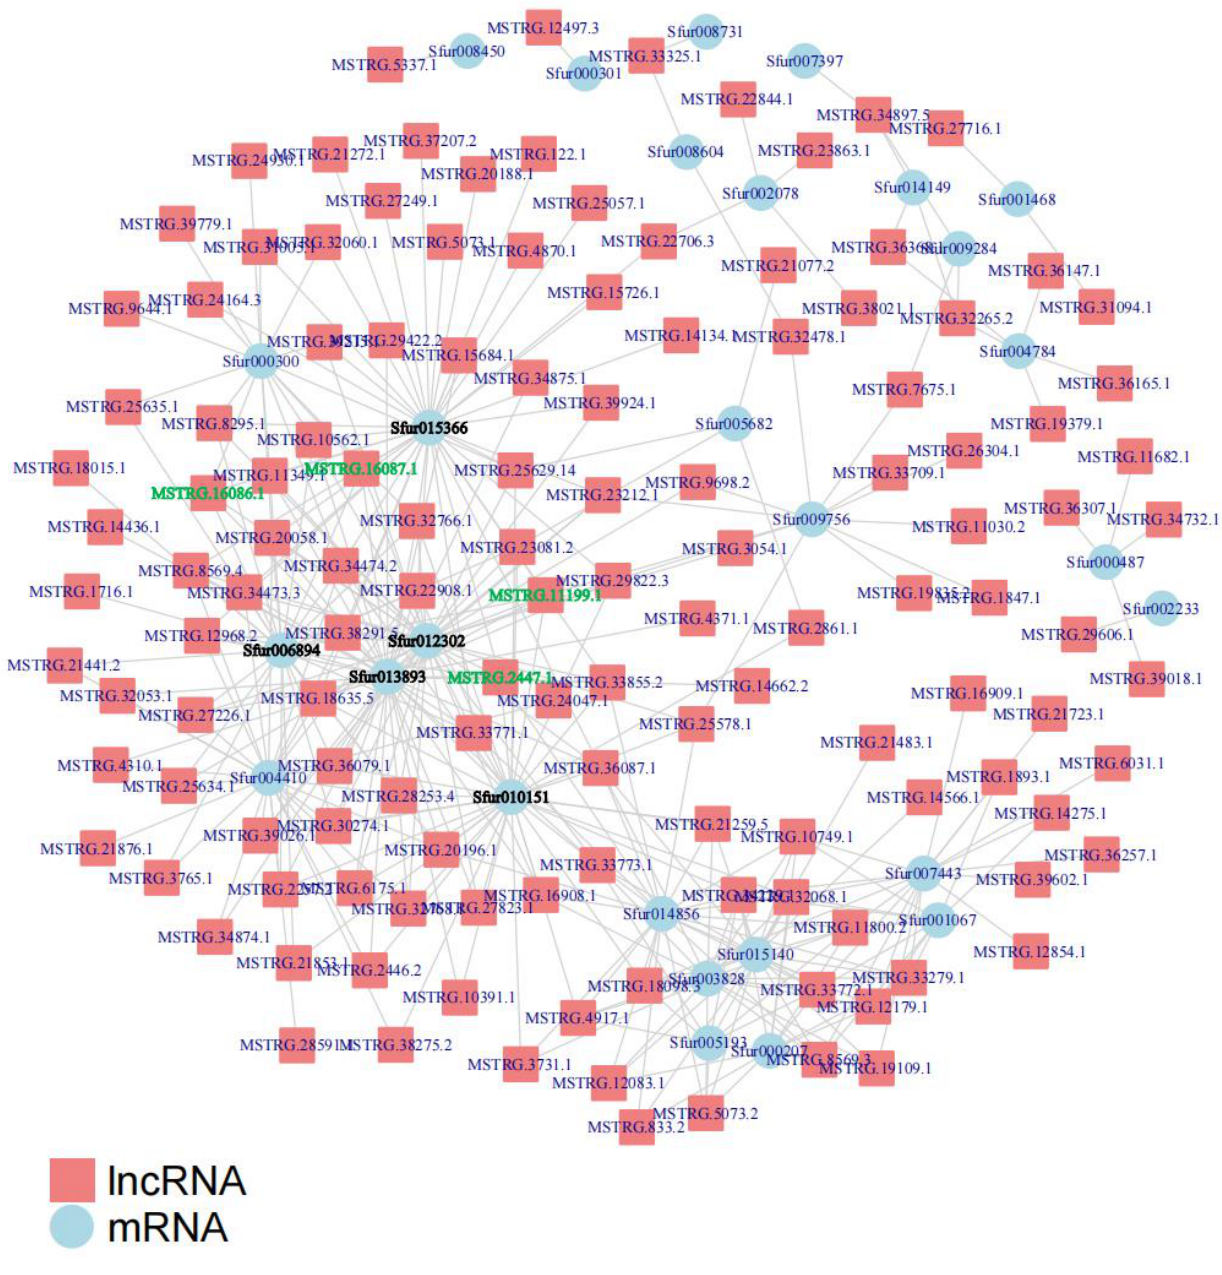
Figure 5. Interaction analysis of lncRNAs and protein-coding genes involved in the molting process using Pearson’s correlation coefficient.